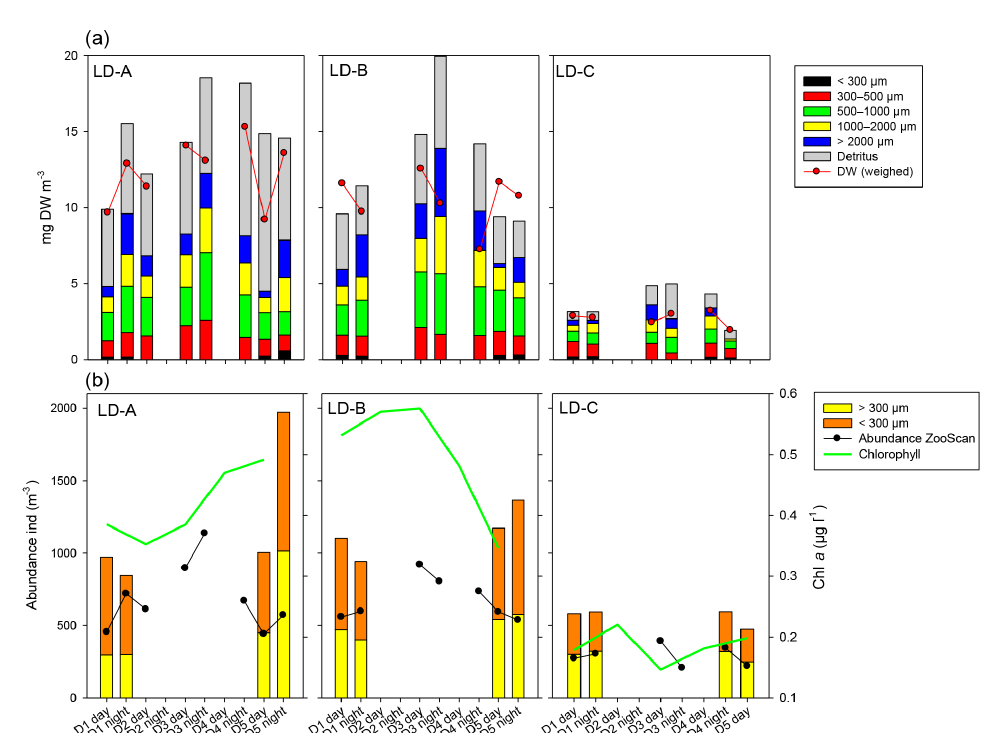
Figure 6. Temporal variation in zooplankton abundance and biomass over 5 days at each of the three long-duration stations (LD-A, LD-B, and LD-C from left to right). (a) Abundance (ind.m − 3 ) of small (ECD < 300µm) and large (ECD > 300µm) zooplankton determined by microscope counting (vertical bars – only for days 1 and 5) and of large zooplankton (ECD > 300µm) determined by ZooScan (dark line). Chl a concentrations (green line). (b) Cumulated zooplankton biomass and detritus sampled. Red line – values of total dry weight determined by weighing at each station. The zooplankton biomass fraction < 300µm was determined from microscopic counting. Zooplankton biomass fractions > 300µm (four fractions) and detritus biomass were estimated from ZooScan